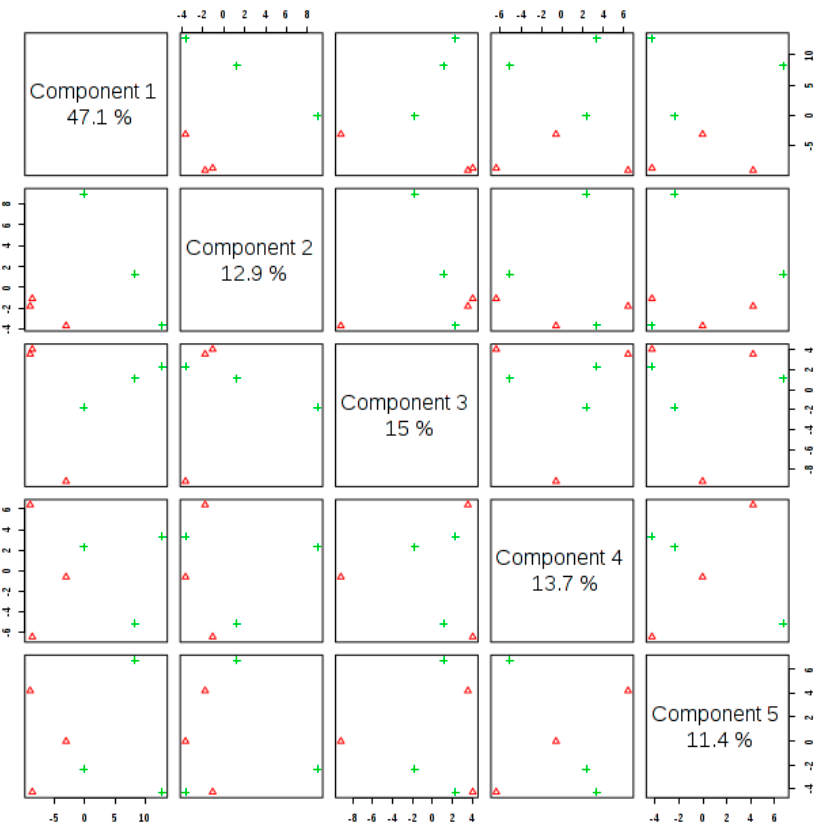
Figure 4. Principal components of the PLS-DA were used for the generation of the two-dimensional graph, which explained 62.1% of the variability of all the data in the metabolic profile of Moringa oleifera leaves extracts. Green triangles represent the samples treated with vermicompost and red cross represents data from the control treatment.